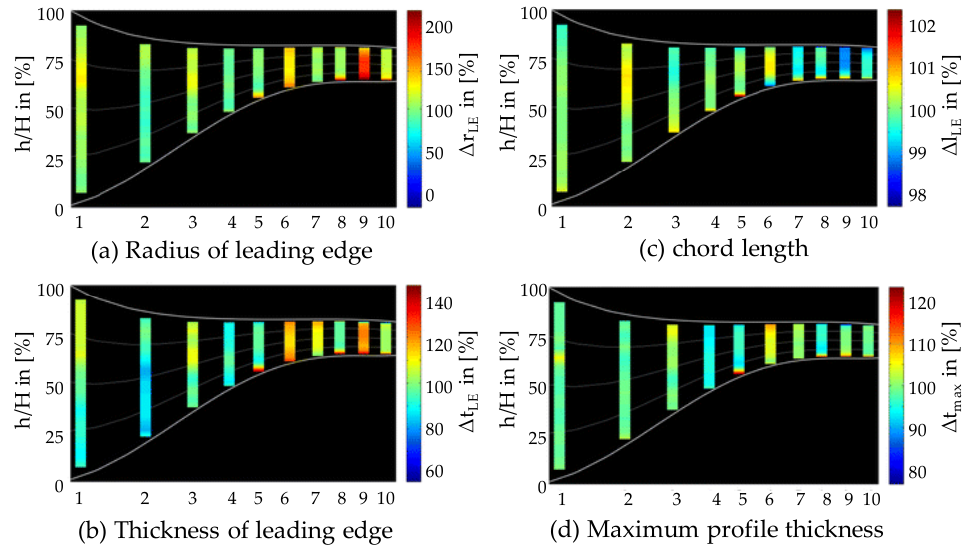
Figure 19. Overall HPC deterioration. Adapted with permission from [29], Copyright Springer, 2014.